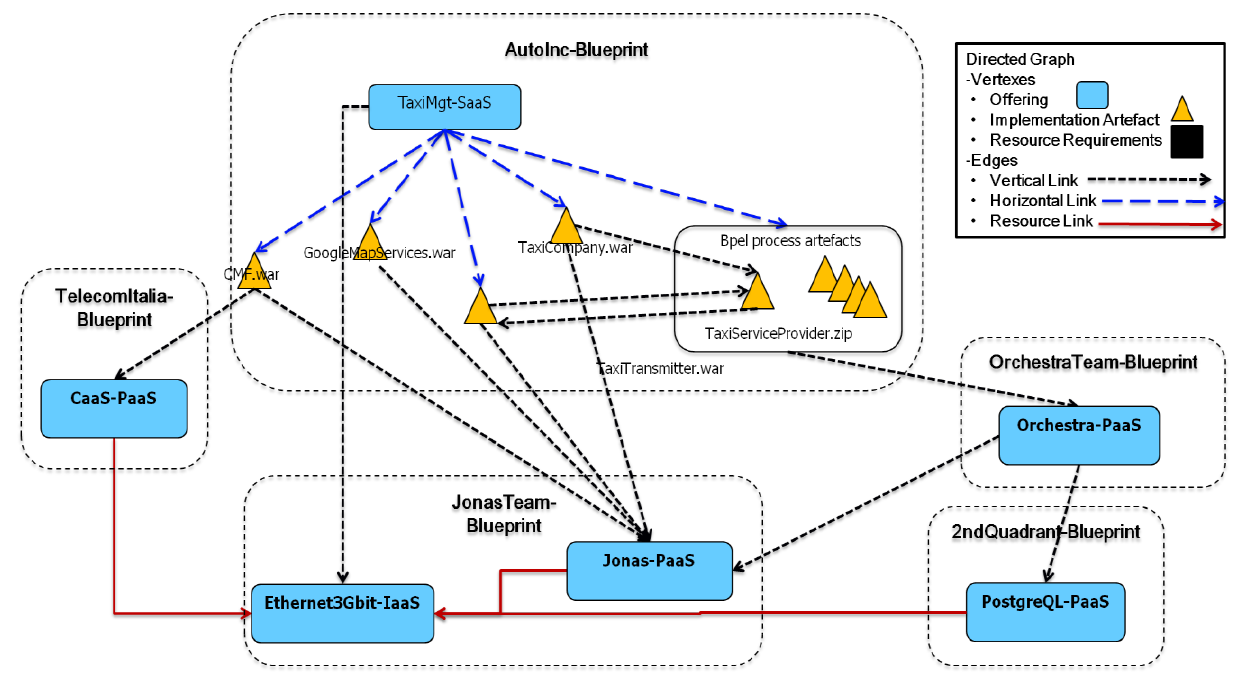
Figure 9. The VA graph of the selected “resolved” AutoInc-Blueprint